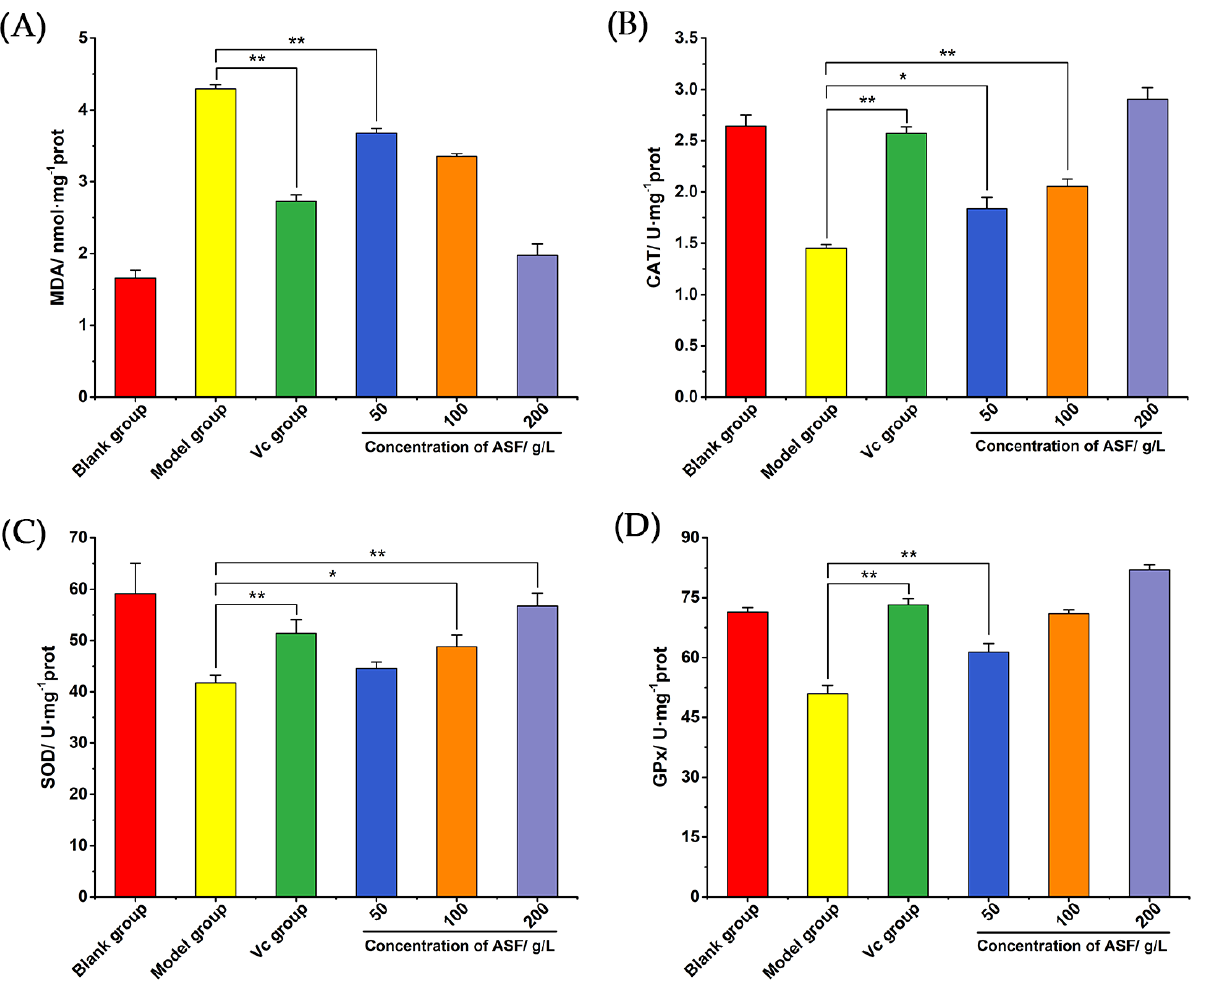
Figure 7. The effects of total flavonoids on MDA and antioxidant enzymes in the colon. ( A ) The effect of A. senticosus flavonoids on the content of MDA in colon tissue. ( B ) The effect of A. senticosus flavonoids on the activity of CAT. ( C ) The effect of A. senticosus flavonoids on the activity of SOD. ( D ) The effect of A. senticosus flavonoids on the activity of GPx. Note: For the comparison between the two groups, * indicates significant difference at p < 0.05. ** indicates extremely significant difference at p < 0.01.